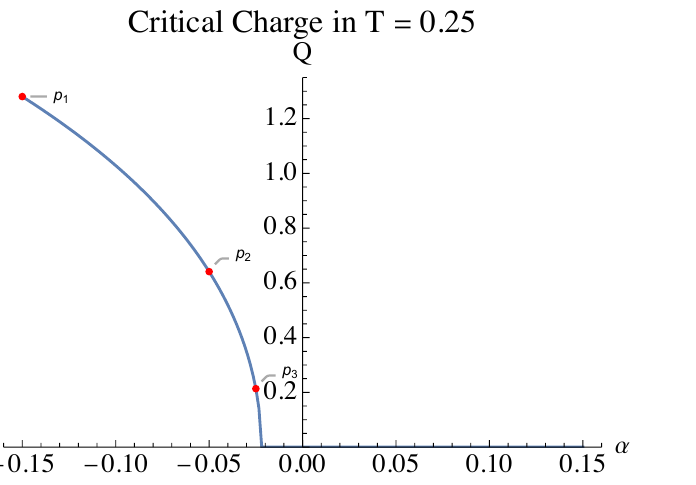
Figure 12 . Critical charge Q for T = 0 . 25